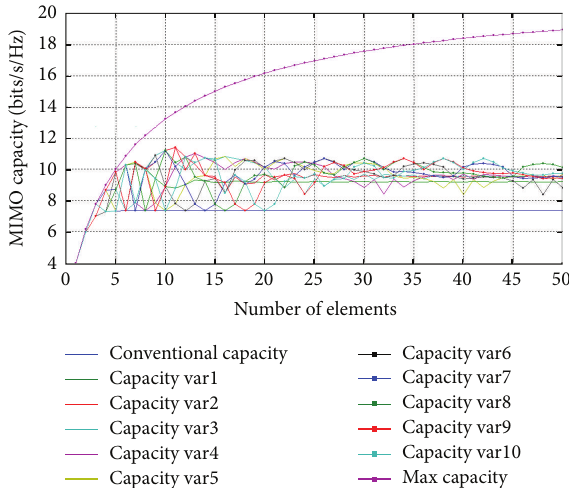
Figure 8: MIMO capacity for the circumference geometry with a SNR = 15 dB and a radius of 0.25 𝑑